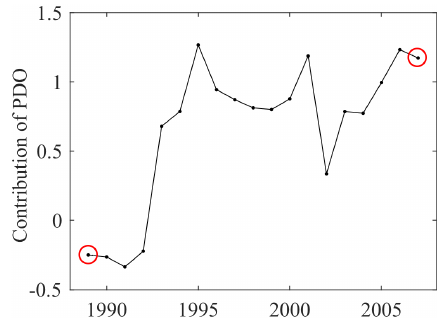
Figure 15. Sliding contribution of the PDO to the DUCMASS– Niño-3 relationship. The two circles represented the 15-year win- dow spanning from 1982 to 1996 and from 2000 to 2014, respec- tively.